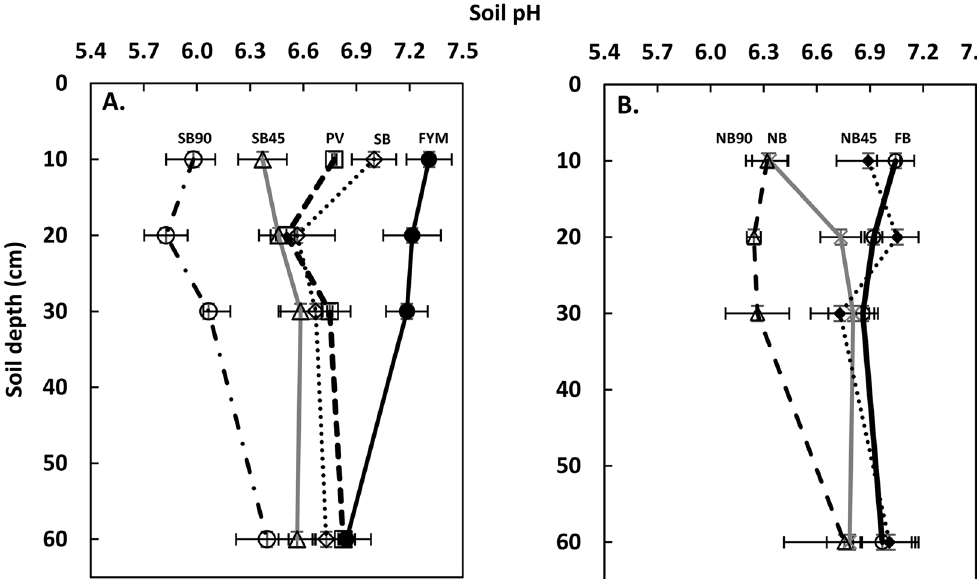
Figure 1. Soil pH depth function as affected by the different agricultural practices of CR-LTE in 2015. ( A ) PV, FYM, SB, SB45, and SB90. ( B ) FB, NB, NB45, and NB90. FB = Fall burn; FYM = Farmyard manure; PV = Pea vine; NB = No burn; SB = Spring burn; and 45 and 90 after NB and SB represents the rates (kg ha − 1 ) of inorganic N applications in respective treatments.